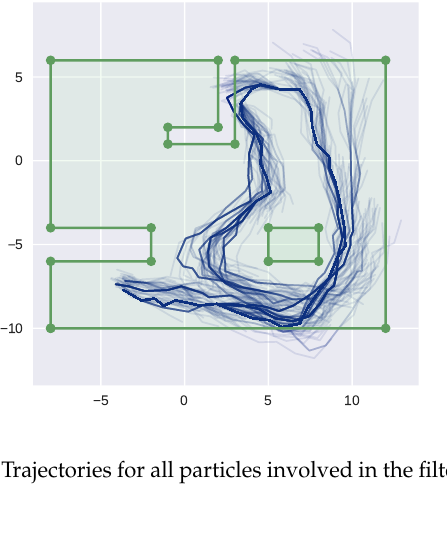
Figure 13. Trajectory results of SLAM on HMs.